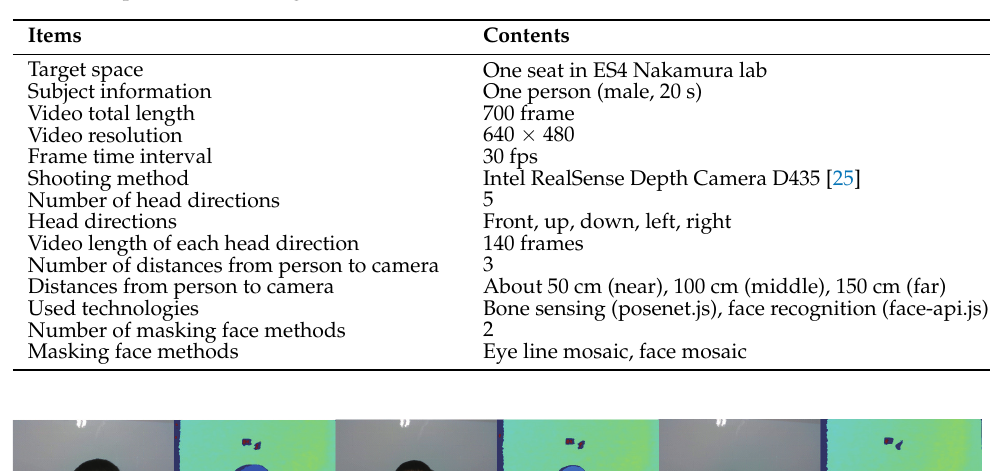
Table 3. Experimental settings.